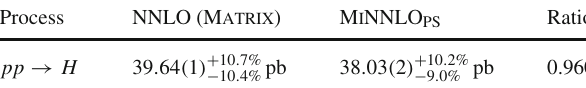
Table 2 Total cross sections of Higgs-boson production. The number in brackets denotes the numerical uncertainty on the last digit